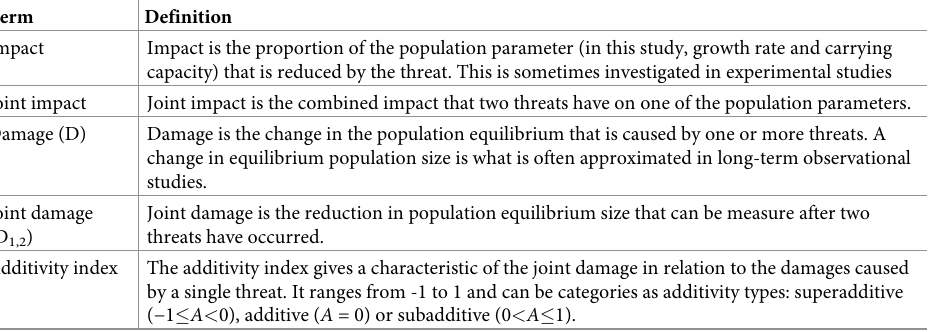
Table 1. Definition and connection of commonly used terms in this